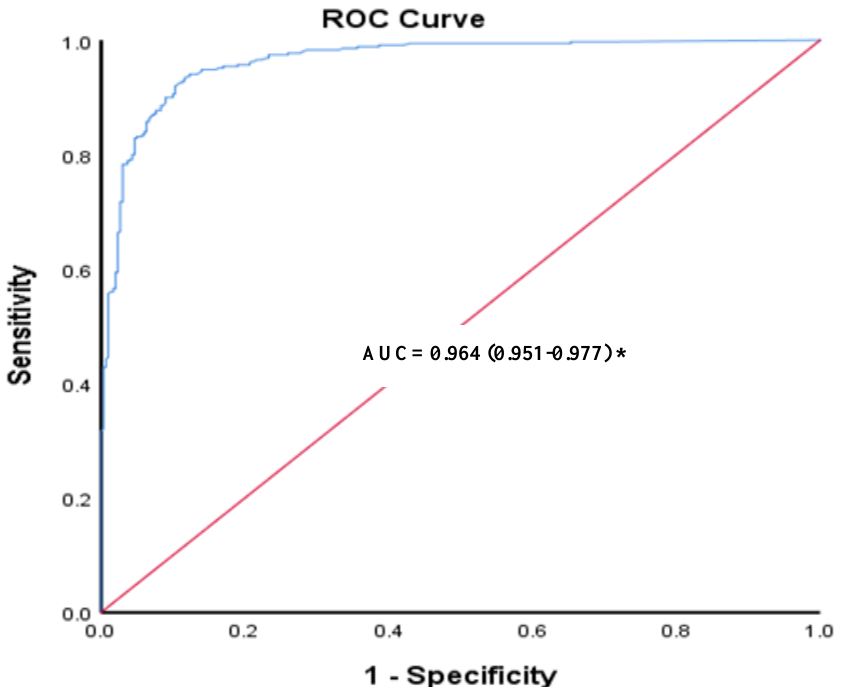
Figure 2. A ROC analysis illustrating the optimized cutoff value for the anti-spike immunoglobulin, in relation to the prevalence of nabs (AUC= 0.964 (0.951–0.977). * p -value < 0.01.